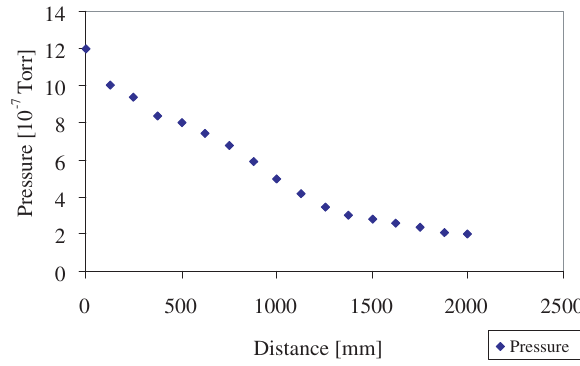
FIG. 17. (Color) Pressure bump vs distance from detector posi-